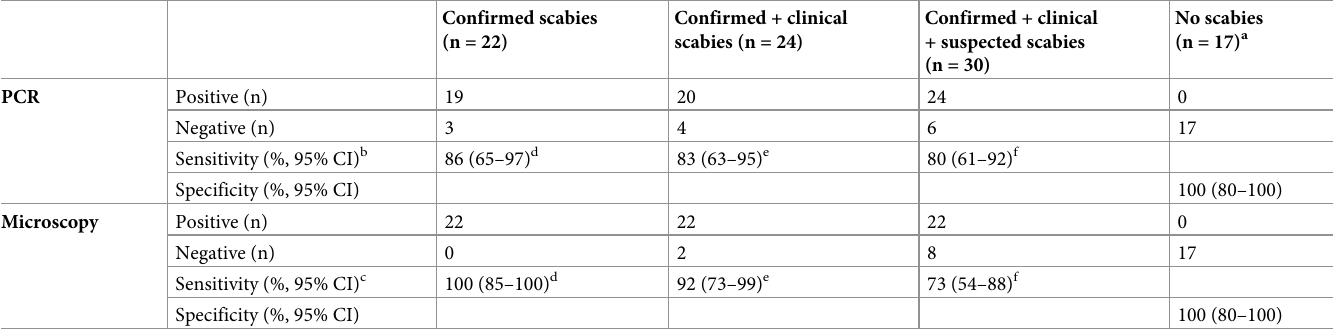
Table 1. Comparison of diagnostic performance of the scabies PCR and microscopy in confirmed, clinical, and suspected scabies